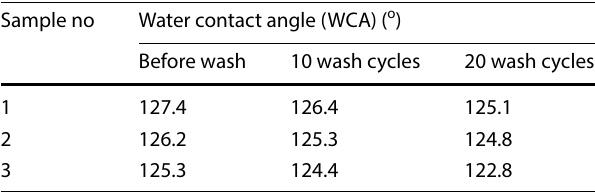
Table 10 Surface durability evaluation of treated nonwoven cotton fabric Sample